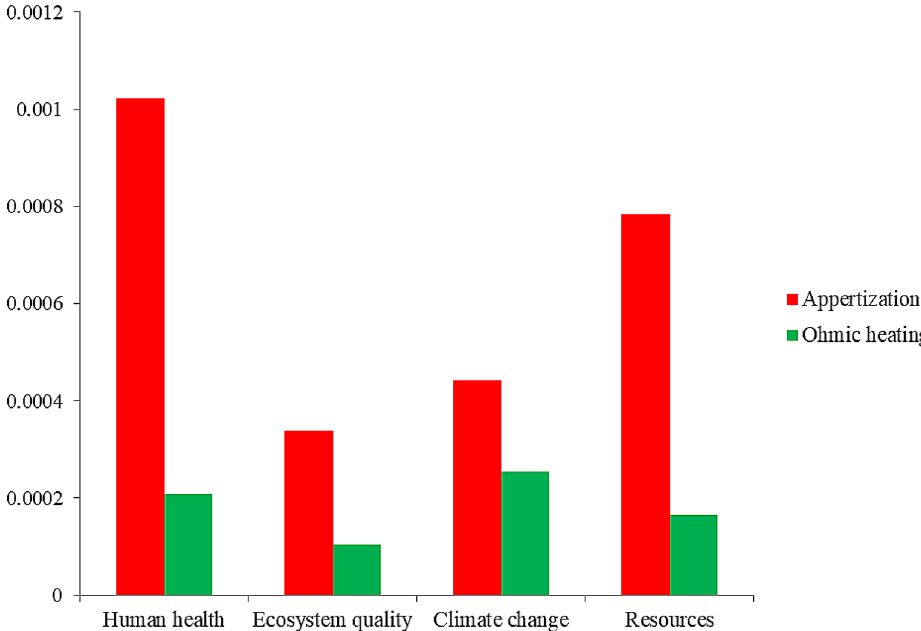
Figure 7. Normalized damage assessment of tomato juice processing and packaging for appertization and ohmic heating systems.